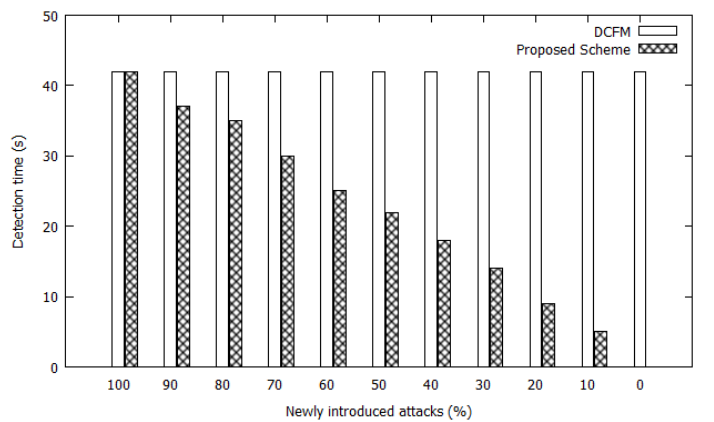
Figure 11. Comparison of the Overall Vulnerability Periods in